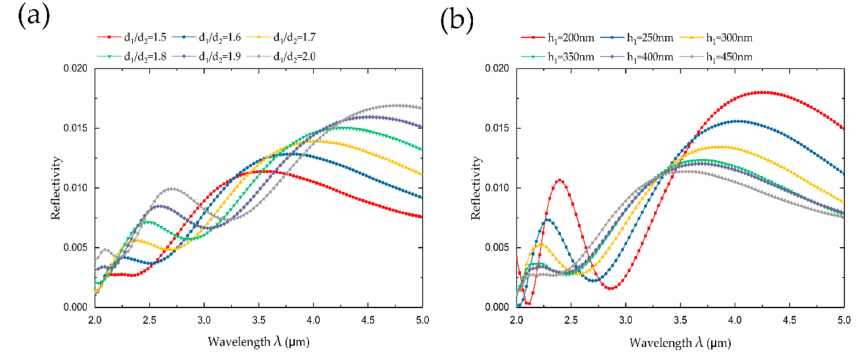
Figure 4. Optimized waist structure parameters: ( a ) reflectivity of structure array with h 1 = 450 nm, and d 1 / d 2 = 1.5–2.0; ( b ) reflectivity of structure array with d 1 / d 2 = 1.5, and h 1 = 200–450